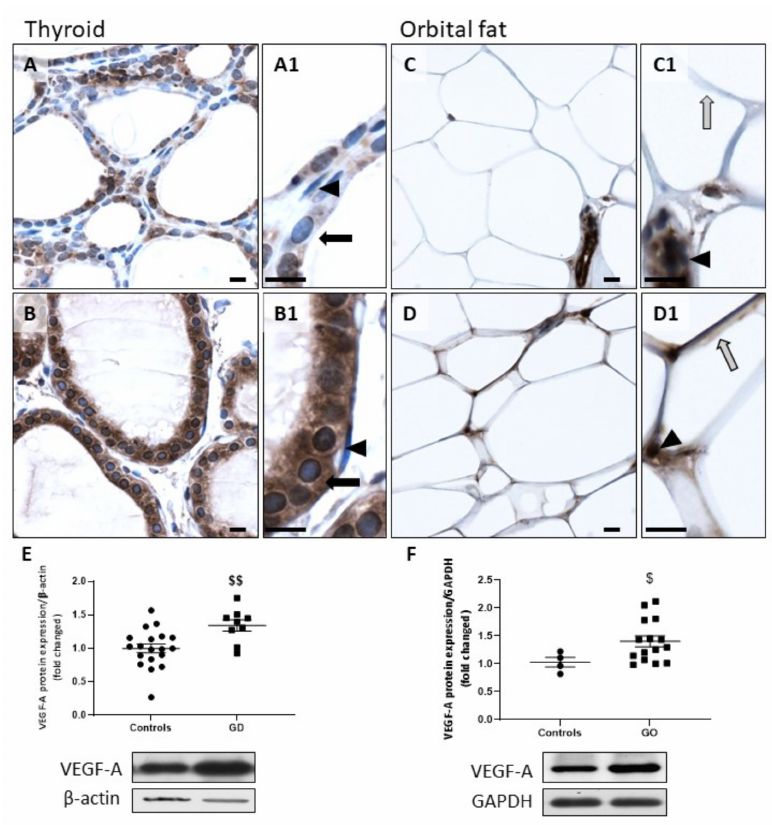
Figure 3. Increase of VEGF-A in GD thyroids and GO orbital fats. VEGF-A staining was predominant in GD thyrocytes ( B ) and GO orbital adipocytes ( D ) versus controls ( A , C ). Thyrocytes are indicated by black arrows, adipocytes by gray arrows, and endothelial cells by arrowheads ( A1 – D1 ). Scale bars = 10 µ m. Western blot quantification of VEGF-A demonstrated an upregulation of this protein in GD ( E ) and GO ( F ) tissues. Data represent the mean ± SEM from 19 controls and 9 GD thyroids and from 4 controls and 15 GO orbital fats. $ p < 0.05 and $$ p < 0.01 compared to controls. Densitometric values were normalized against β -actin or GAPDH. Western blots shown are representative of both